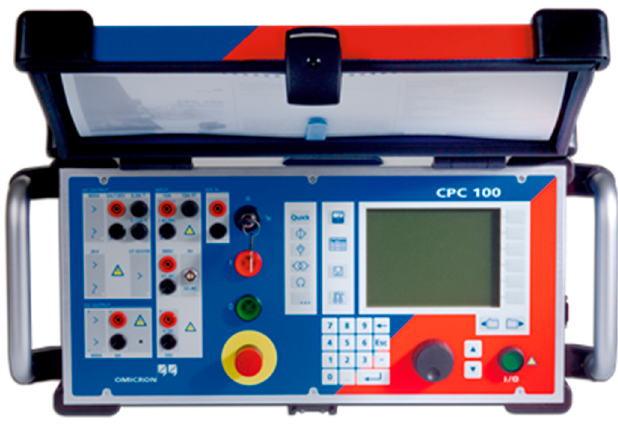
Figure 4. CPC 100 Measurement Device.